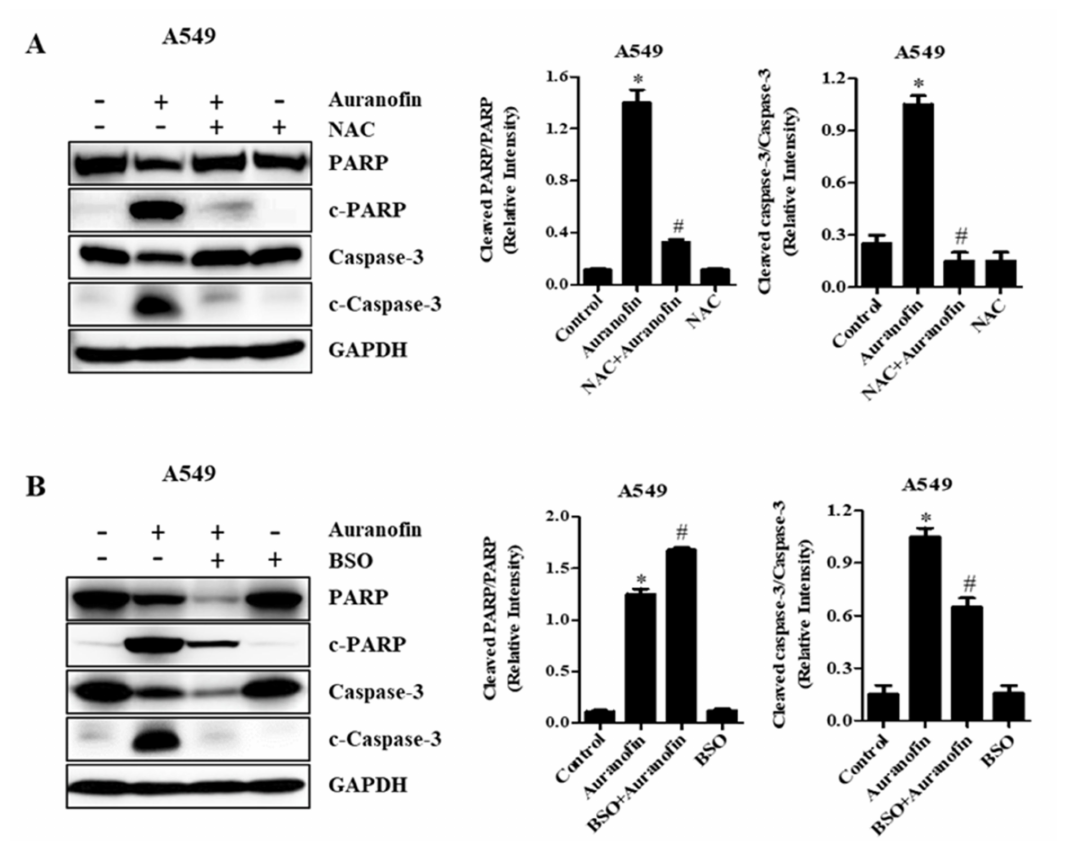
Figure 7. Effects of NAC and BSO on apoptosis-related protein levels in auranofin-treated A549 cells. Exponentially growing A549 cells were incubated in 5 µ M auranofin for 24 h following 1 h preincuba- tion with 2 mM NAC or 10 µ M BSO. Whole-cell extracts were prepared, and equal amounts of lysates were then resolved through SDS-PAGE, transferred onto PVDF membranes, and immunoblotted with the indicated antibodies against PARP, cleaved PARP, procaspase-3, cleaved caspase-3, and GAPDH ( A , B ). GAPDH detection was used to confirm equal protein loading. Graphs show ratio of cleaved PARP/PARP and cleaved caspase-3/caspase-3 in auranofin-treated A549 cells, and band intensities were quantified using the Image J program ( A , B ). * p < 0.05 compared with auranofin-untreated control cells. # p < 0.05 compared with cells treated with auranofin